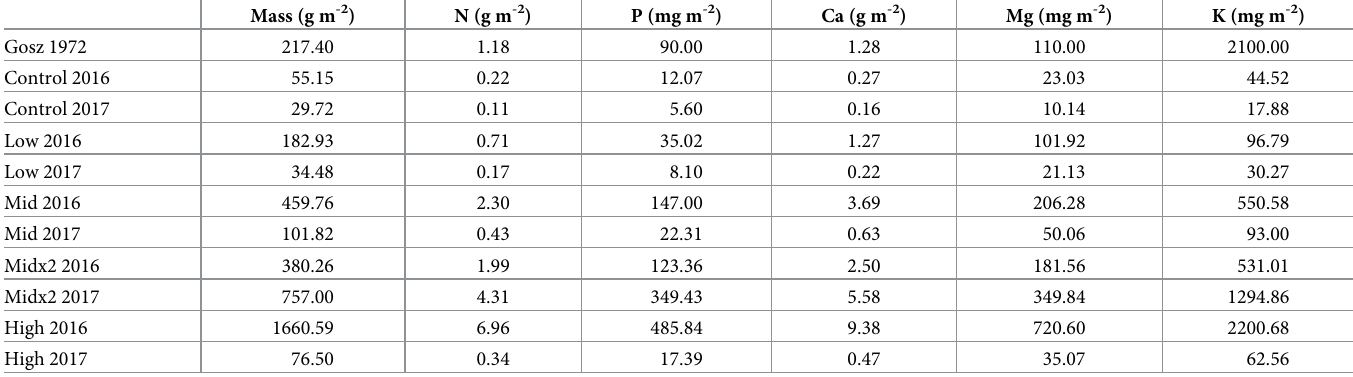
Table 8. Combined input of Hubbard Brook ice storm experiment coarse and initial fine woody debris, and historic input of litter in perennial woody tissues repro- duced from Gosz et al.